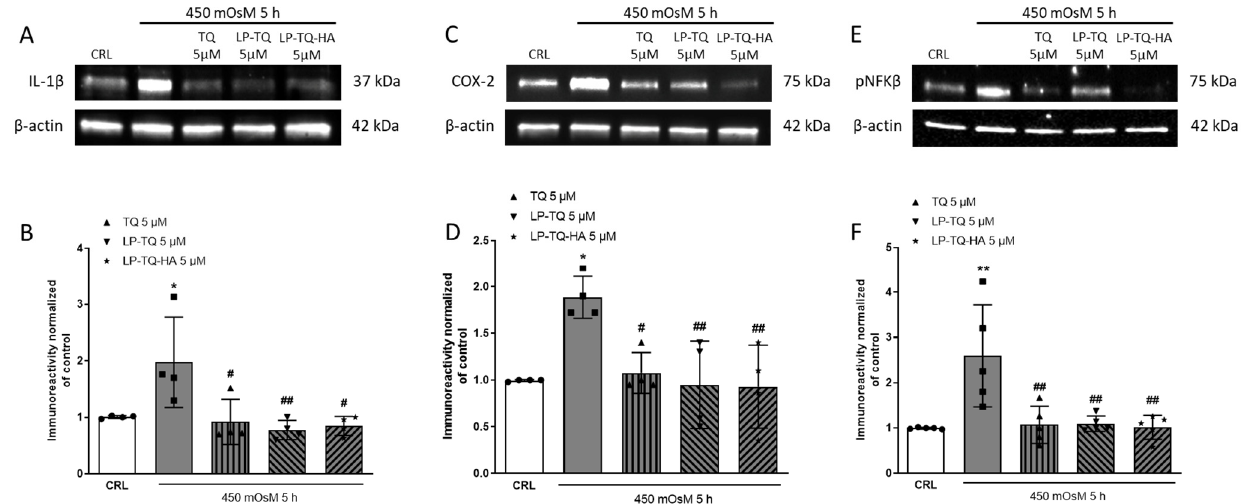
Figure 3. The effects of TQ on proinflammatory signaling in HCE-2 cells exposed to hyperosmotic media. Cells were exposed to 450 mOsM for 5 h and then processed for WB. The TQ-free and formulated were present in the incubation medium during hyperosmolarity exposure. ( A , C , E ) Repre- sentative blots for IL-1 β or COX-2 or NF-kappa-B p65 or β -actin. ( B , D , F ) the quantitative analysis of immunoreactive bands, showing that TQ is able to reduce the increase levels of proinflammatory protein induced by 450 mOsM for 5 h. Dot blots show the results of four experiments. * p < 0.05 and ** p < 0.01 vs. CRL; # p < 0.05 and ## p < 0.01 vs. hyperosmolarity. (ANOVA + Tukey’s w-test).